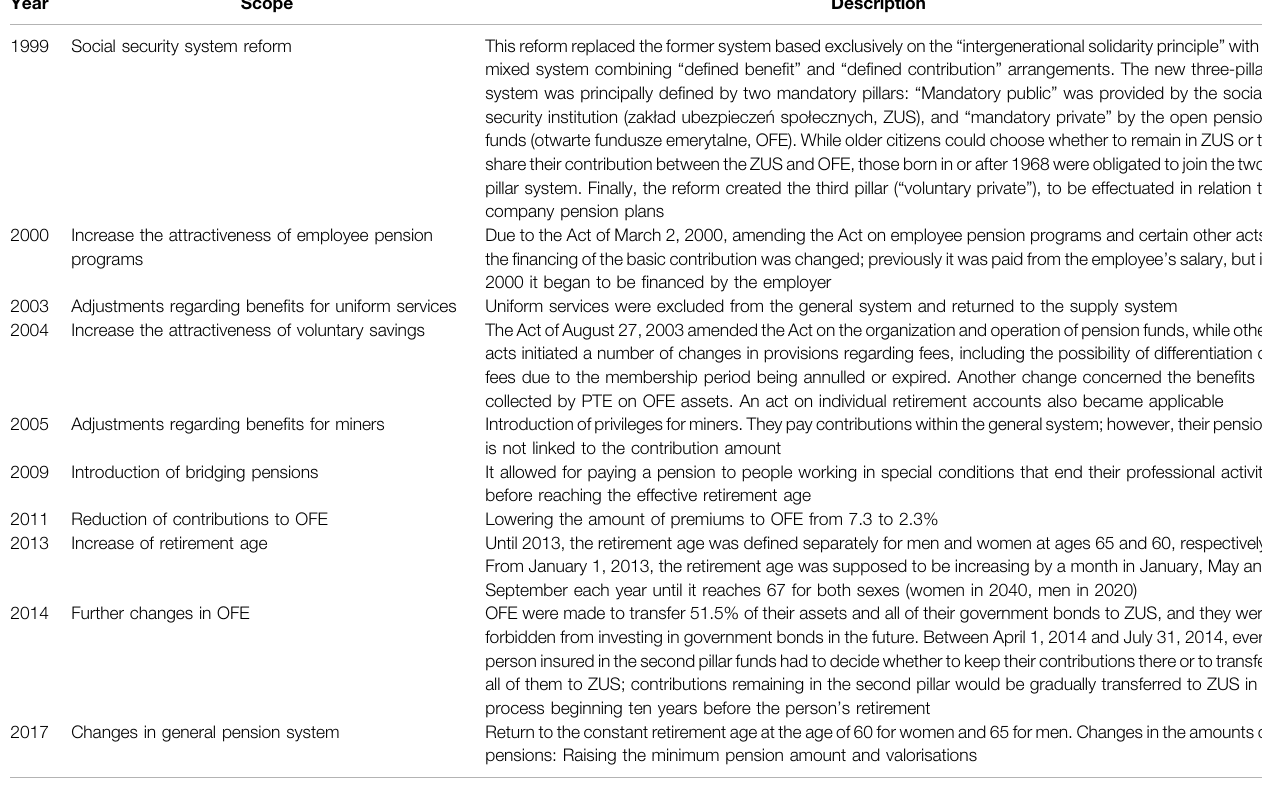
TABLE 1 | Changes in pension system in Poland between 1999 –